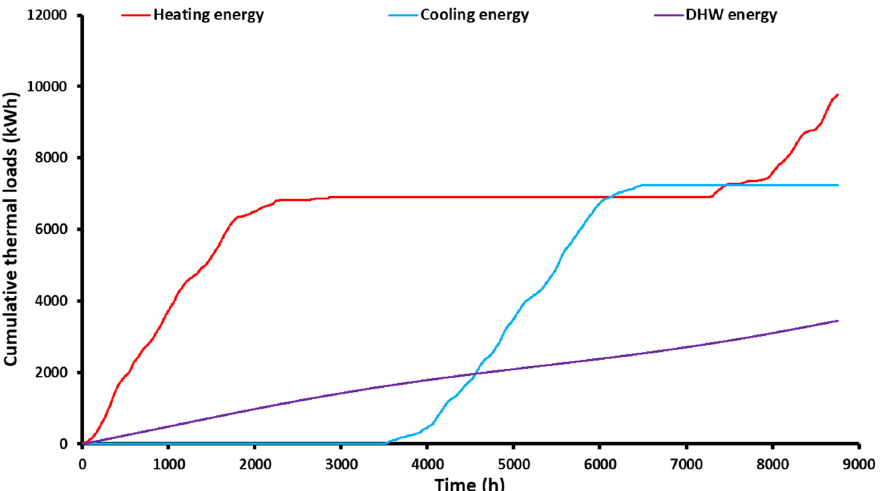
Figure 7. Cumulative thermal loads for heating, cooling, and DHW of the studied building.